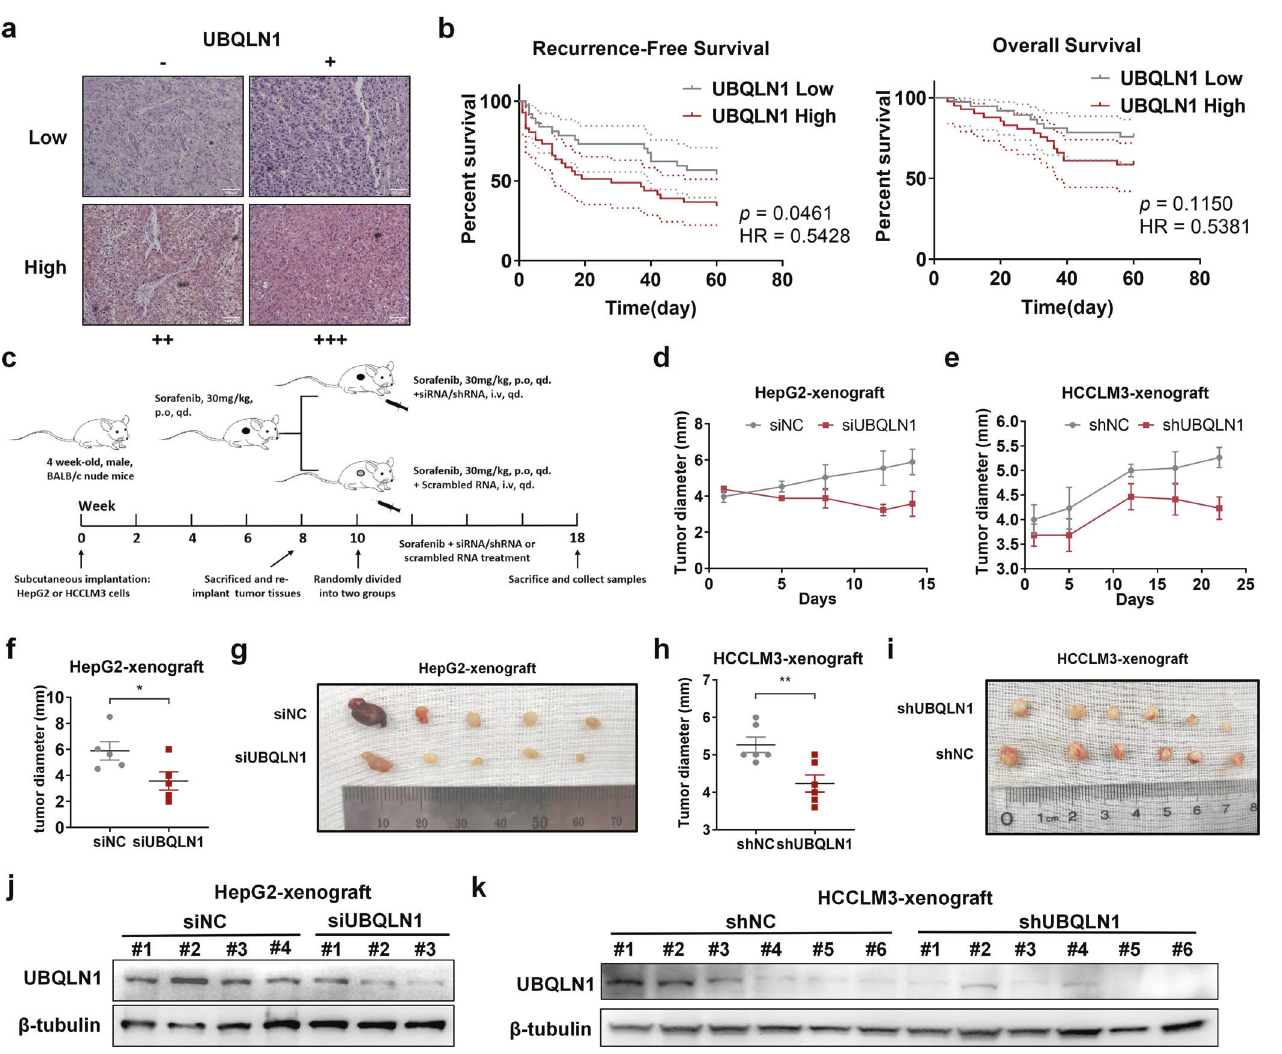
Fig. 7 The role of UBQLN1 in HCC prognosis and sorafenib resistance in vivo. a Representative IHC images of UBQLN1 expression in HCC clinical samples. Patients were divided into two groups. The low expression group included patients with negative and weak expression of UBQLN1, and the high expression group included patients with moderate and strong expression of UBQLN1. b The survival curves of recurrence-free survival and overall survival were calculated using the log-rank test. c Flow chart of the establishment of sorafenib-resistant mouse models. siRNA transfection was adopted to reduce UBQLN1 levels in tumors. d , e The size of xenograft was measured in vivo every 3 – 4 days using Vernier caliper. f The size of HepG2-xenograft was measured in vivo by caliper prior to sacri fi ce. g Subcutaneous HepG2- xenograft from both groups were harvested. h The size of HCCLM3-xenograft was measured in vivo by Vernier caliper prior to sacri fi ce. i Subcutaneous HCCLM3-xenograft from both groups were harvested. j , k Western blot analysis of UBQLN1 and β -tubulin in tumors harvested from the mouse models described in c . * p < 0.05 and ** p < 0.01. NS not statistically signi fi cant. UBQLN1: